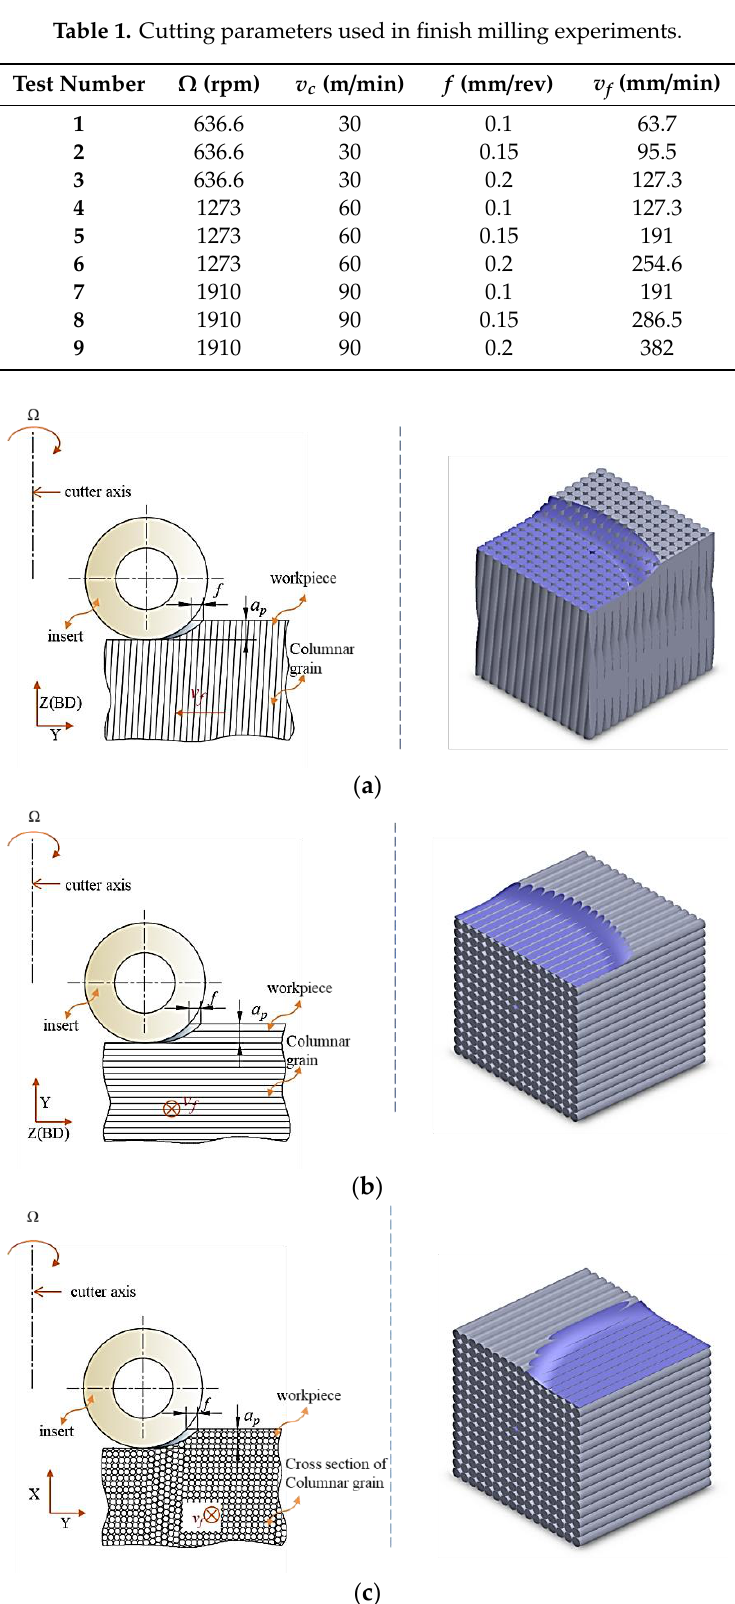
Figure 3. The relative orientation of milling insert to the build direction (BD) (left) and the illustration of the machined surface (right): ( a ) case 1: cutting against columnar grains; ( b ) case 2: cutting along columnar grains in horizontal direction; ( c ) case 3: cutting along the columnar grains in vertical direction.